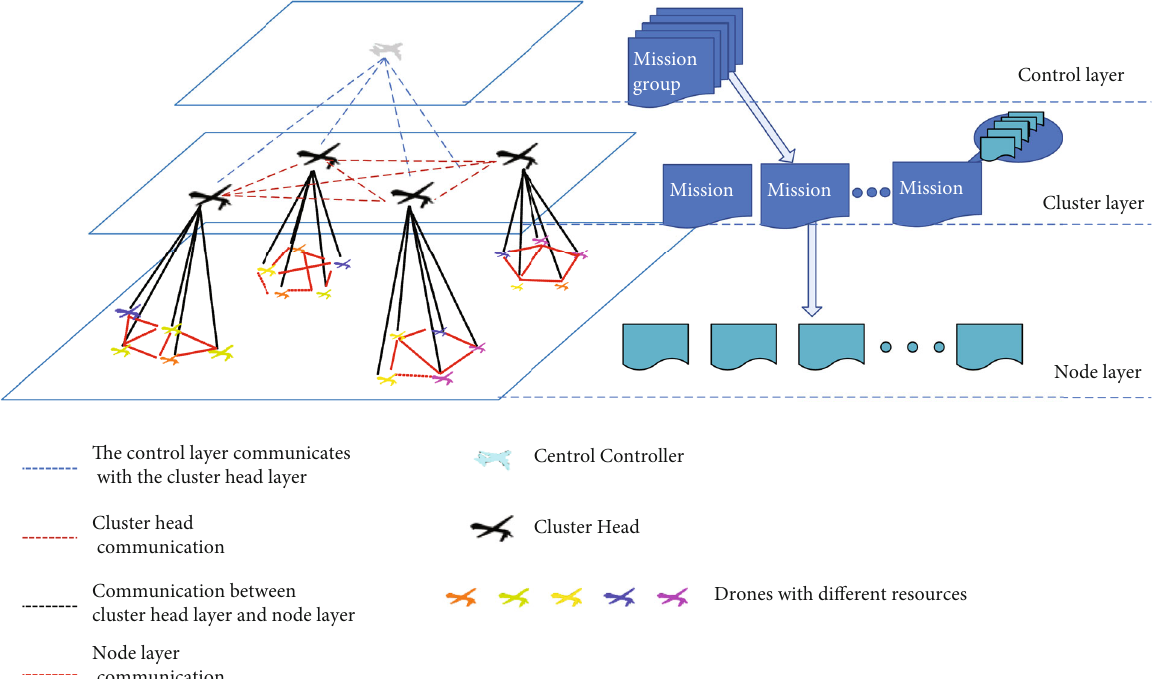
Figure 5: Mapping strategy of UAV cluster network architecture and mission task decomposition.